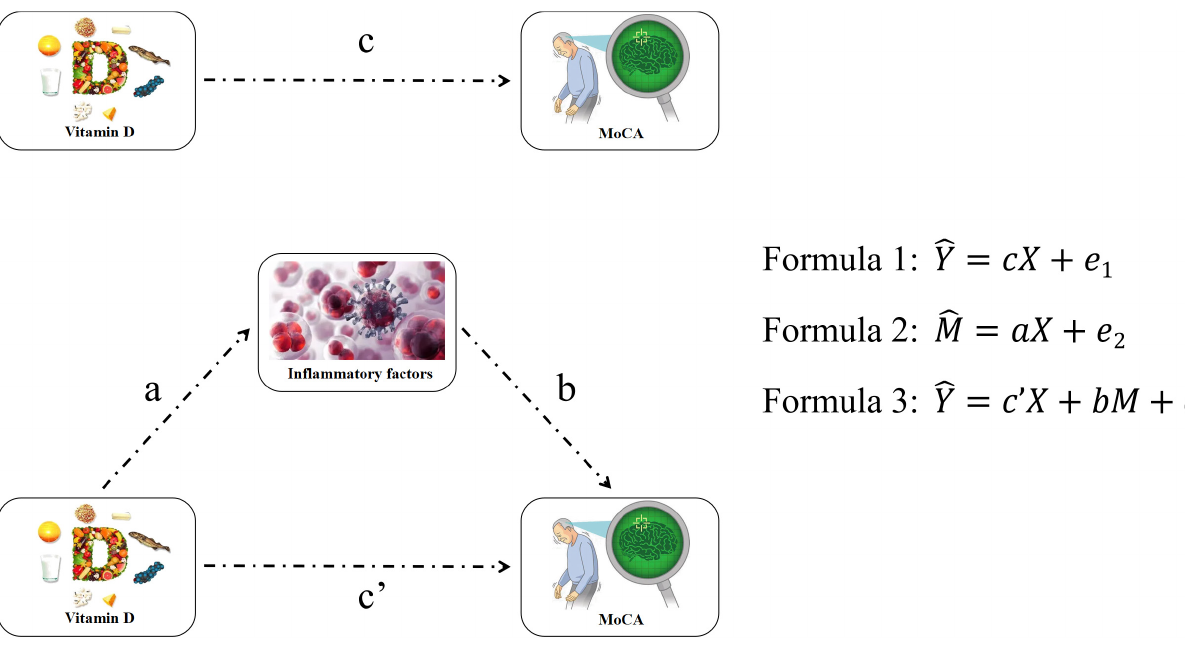
Frontiers in Aging Neuroscience |